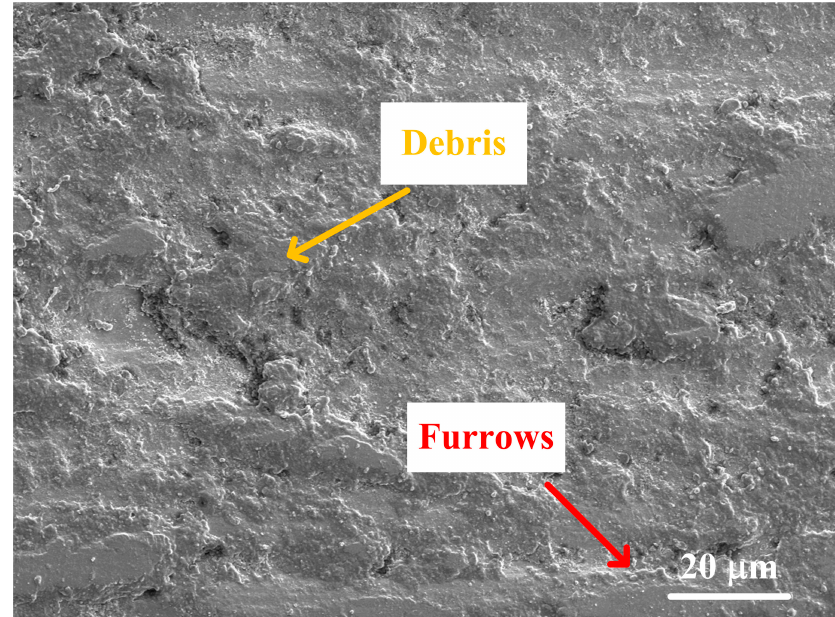
Figure 13. Wear morphology of the substrate.